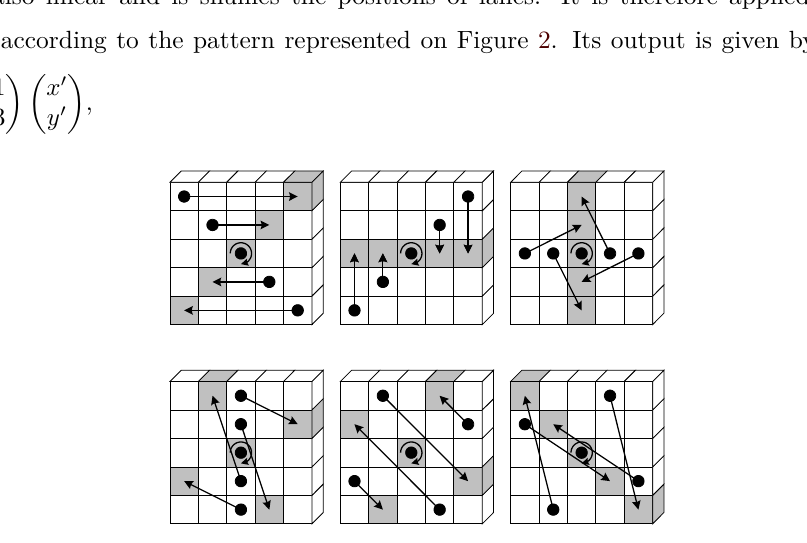
Figure 2: Representation of π on each slice of the